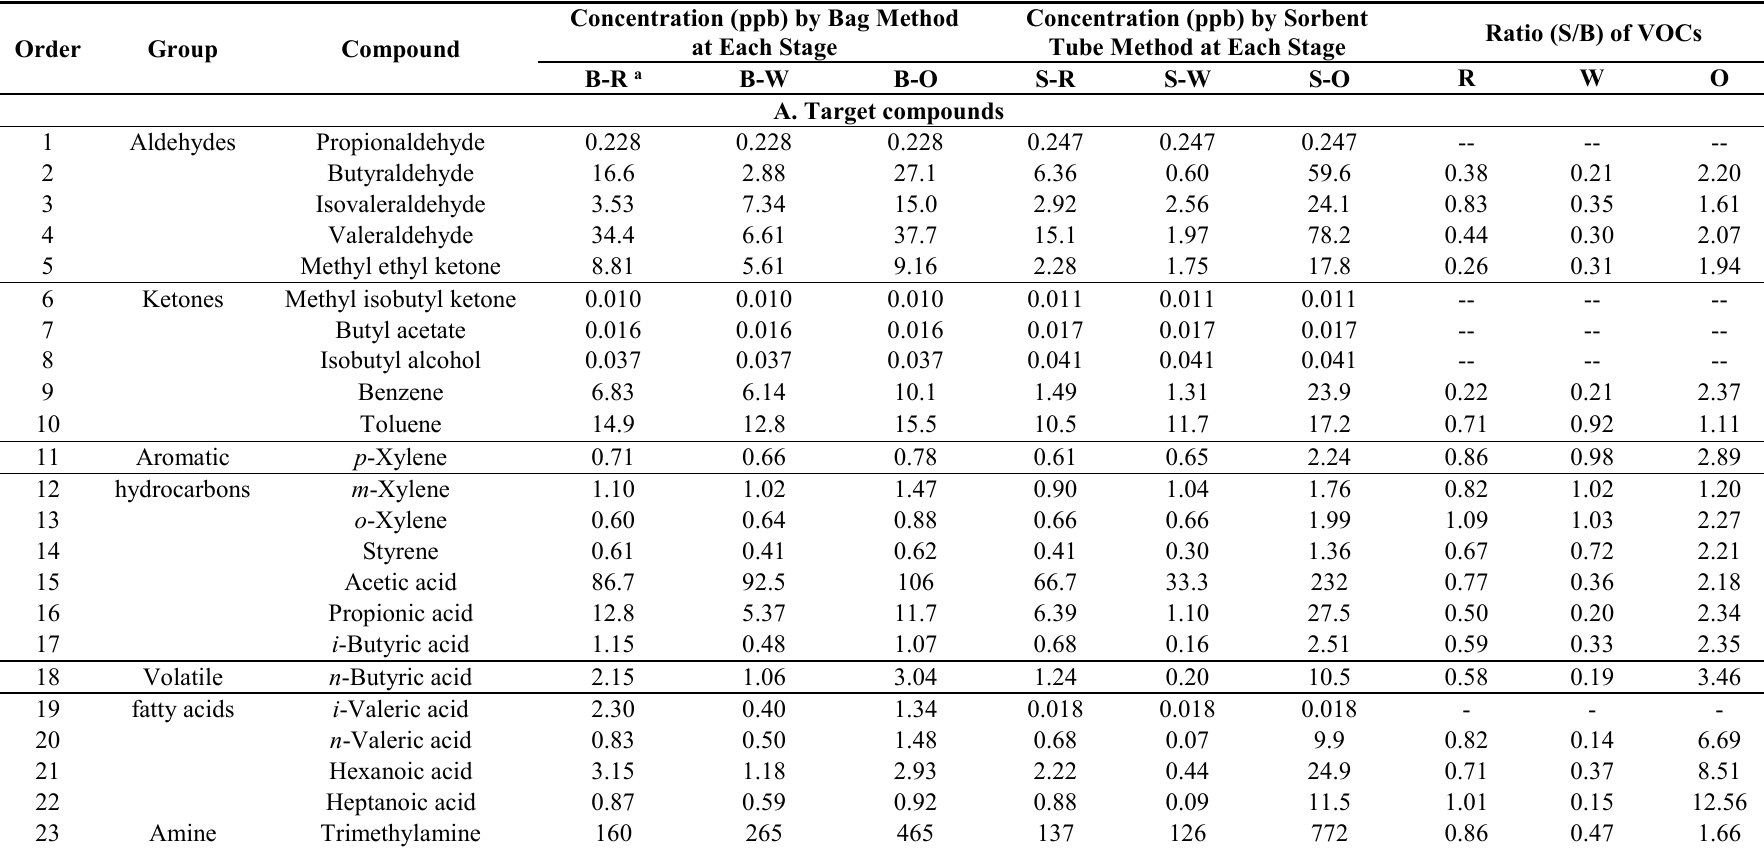
Table 5. Concentration (ppb) and ratio between the two sampling methods (sorbent tube/bag (S/B)) of VOCs measured from gases samples collected at each frying